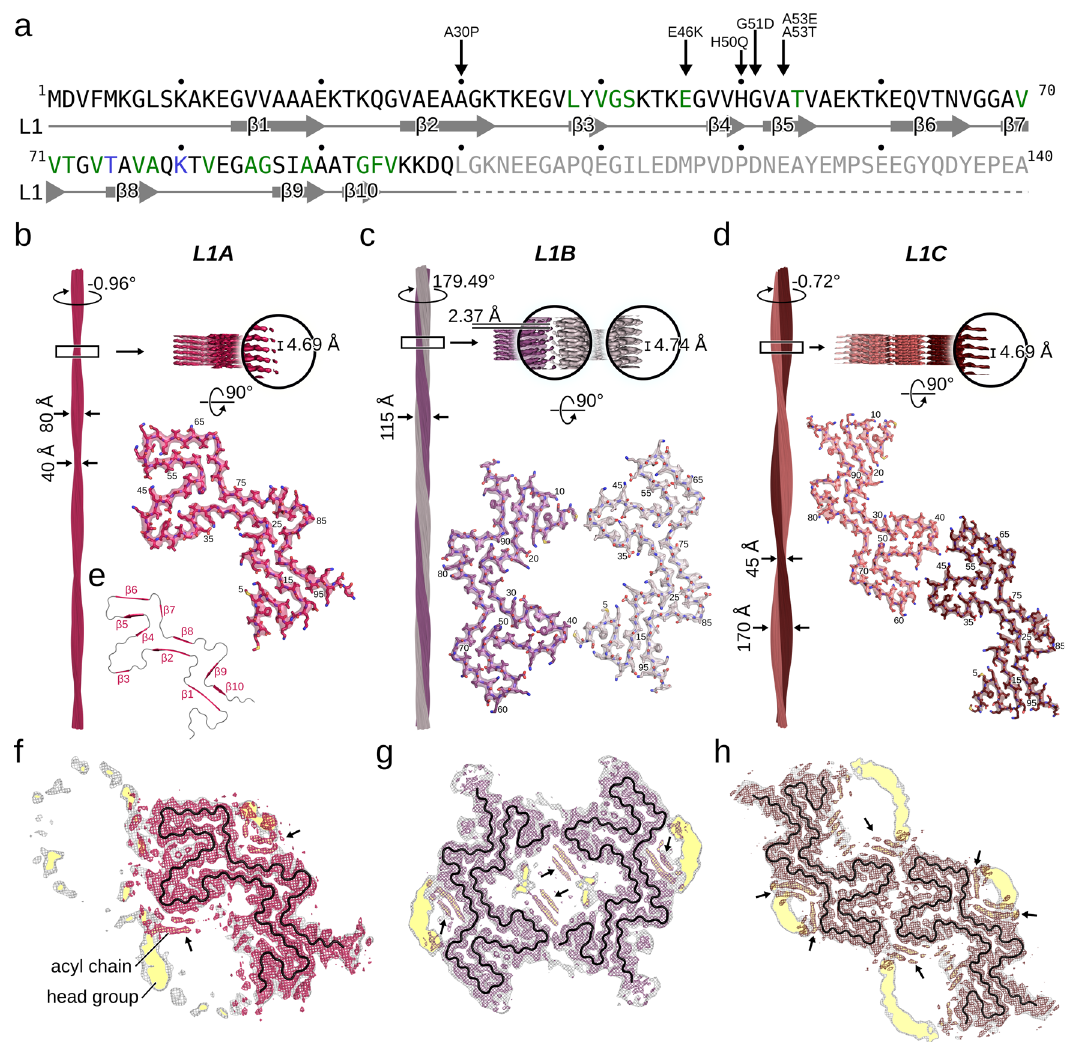
Fig. 1 | Cryo-EM structures of the L1 α Syn fi brils. a Sequence and secondary structureofhuman α Syn.FamilialPDmutationsites(blackarrow)localizedwithinthe lipid binding N-terminal region (residues 1 – 60) 64 . Green-colored residues bind to the lipidacylchain,bluetothecholinemoiety 20 ,andgraywerenotresolved. b – d Cryo-EM structures of L1A ( b ), L1B ( c ), and L1C ( d ) fi brils (proto fi laments colored differently). Theatomicmodelsareshownassticks.Labelsdenotethe fi brilwidth,thehelicaltwist